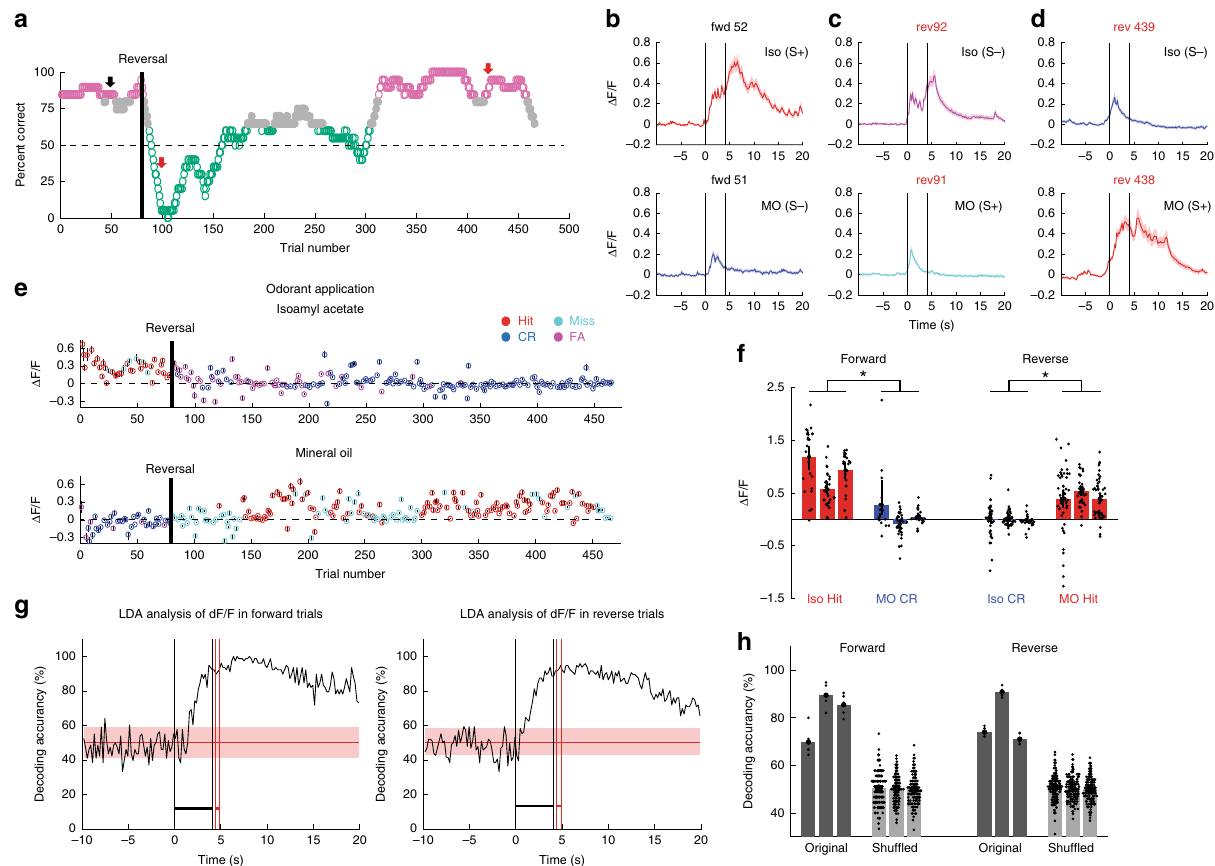
Fig. 4 MLI odorant responses switched after reversal. a – e , g Show behavioral performance ( a ), Δ F / F ( b – e ) and LDA analysis ( g ) for one session where odorant reinforcement was reversed (one mouse). a Learning curve showing the animal ’ s behavior after reversal. Green ≤ 65%, magenta: ≥ 80% correct. Forward: S + 1% Iso and S − MO. n = 20 trials within a sliding window. b – d Average Δ F / F time courses for example trials before (trials 51 and 52) and shortly after reversal (trials 91 and 92), and after the animal attained pro fi ciency during reversal (trials 438 and 439). The vertical black lines are odorant onset and removal. e Per trial average Δ F / F during the last second of odorant application for the reversal task in Fig. 4a. The upper plot shows the responses to Iso and the lower plot shows responses to MO. n = 1 mouse, 185 ROIs. f Average odorant-induced changes (mean ± 95% CI) in Δ F / F recorded from three animals computed for trials when the animal was behaving ≥ 80% correct. Red: Hit, Blue: CR. A GLM analysis indicates that there is a signi fi cant difference in odorant-induced changes in Δ F / F for both odorant and reversal ( p < 0.001, 12 observations, 8 d.f., n = 3 sessions, 3 mice, GLM F- statistic = 14.8, p < 0.01). g Time course for decoding accuracy computed with LDA analysis of Δ F / F data for all ROIs in the FOV. The shade is the 95% CI of decoding accuracy calculated with shuf fl ed odorant identity. The vertical black lines are odorant onset and removal and the red lines bound the reinforcement period. h Average decoding accuracy (mean± 95% CI) for three animals calculated with odorant-induced changes in Δ F / F from trials where the animal was performing ≥ 80% correct. Dark-gray: original, light gray: shuf fl ed. A GLM analysis indicates that differences in decoding accuracy are statistically signi fi cant between original and shuf fl ed ( P < 0.001), but not between forward and reverse ( p > 0.05, n = 12, 8 d.f., n = 3 sessions, 3 mice, GLM F-statistic = 16, p <